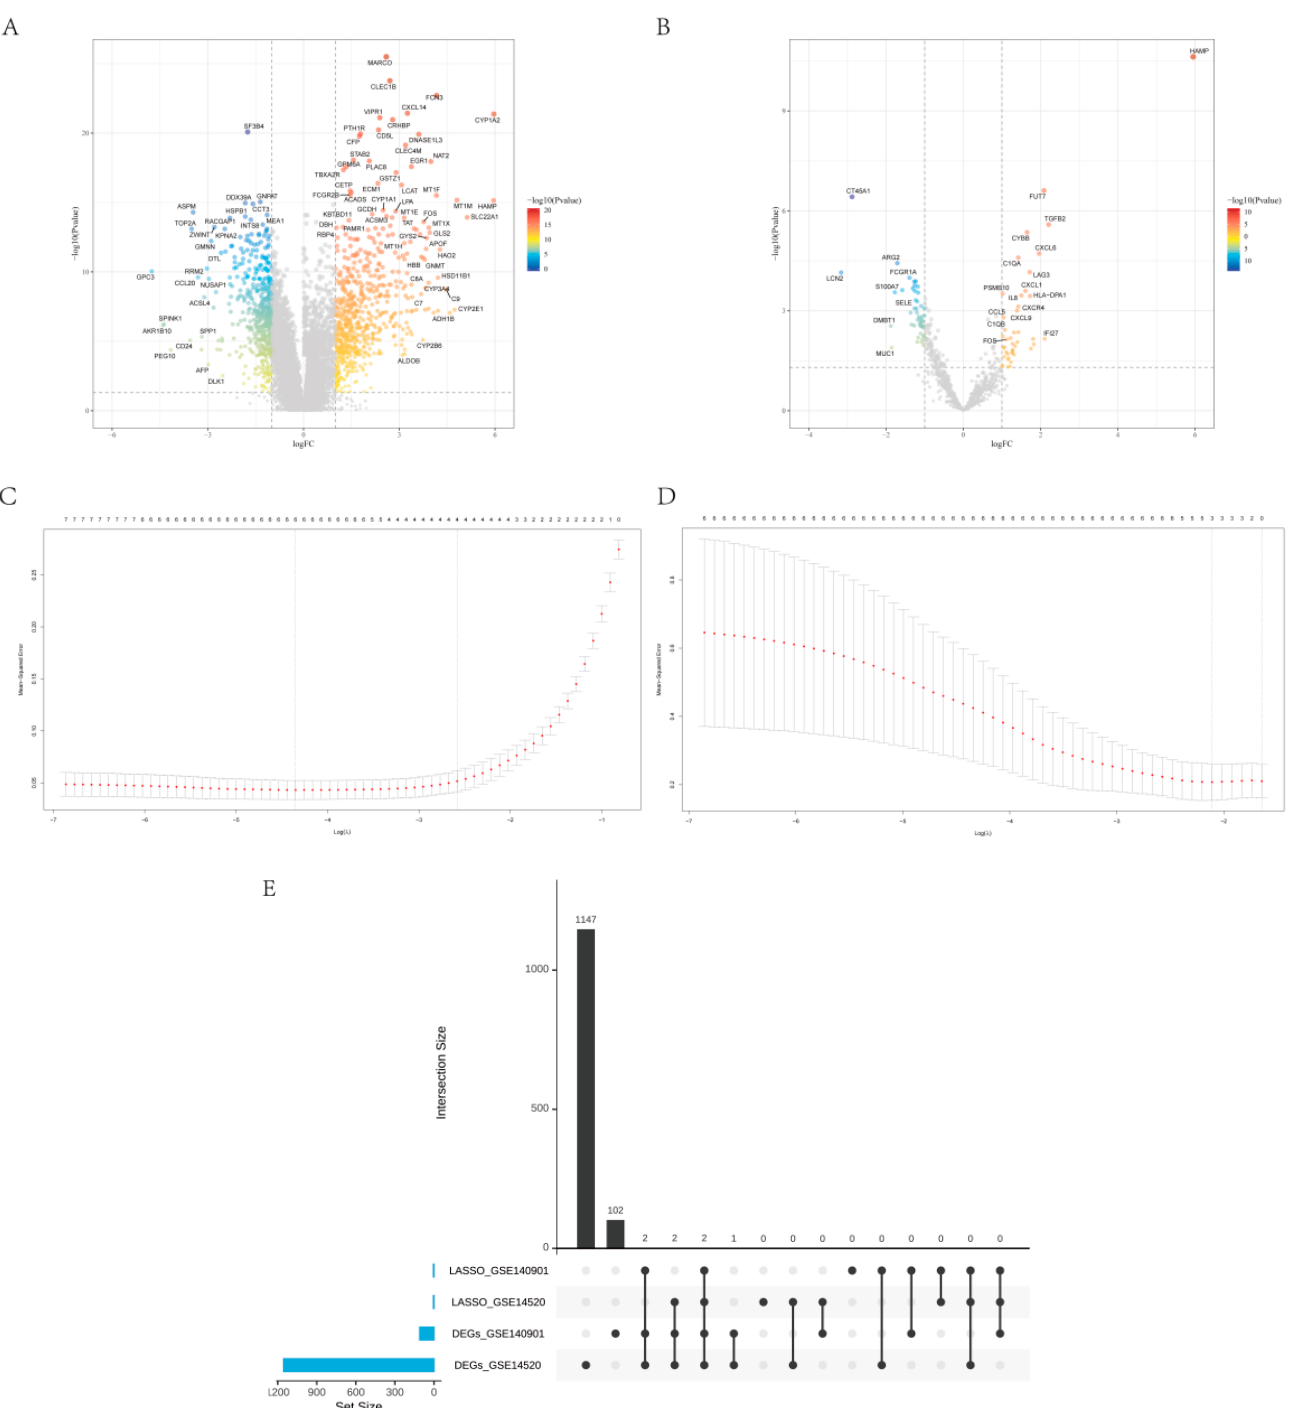
Figure 1. ( A ) Volcano plot of DEGs in GSE14520; ( B ) volcano plot of DEGs in GSE140901; ( C ) Lasso regression of DEGs in GSE14520; ( D ) Lasso regression of DEGs in GSE140901; ( E ) DEGs upset dia- gram.